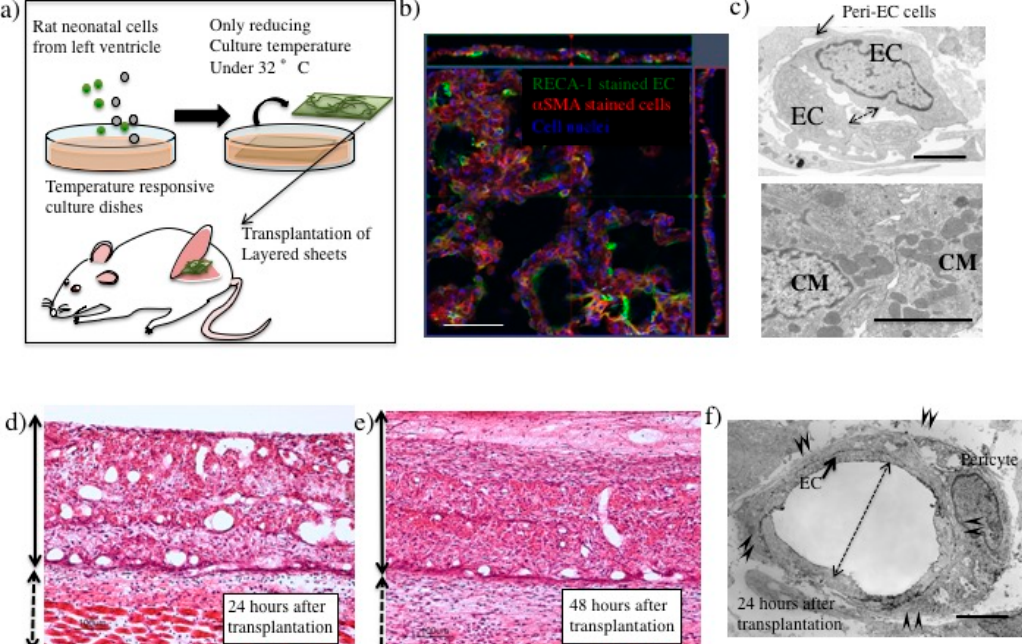
Figure 2. The pathological assessments of donor myocardial cell sheets before and after transplantation. ( a ) Procedures for myocardial cell sheet transplantation into rats. ( b ) Image of immunofluorescence staining of myocardial cell sheet cultured for 4 days in vitro by confocal microscopy. EC (rat endothelial cell antigen (RECA)-1: green), peri-EC cells ( α SMA: red), nuclei (Hoechst 33258). ( c ) Electron microscopic analysis of ECs and cardiomyocytes (CMs) in myocardial cell sheets cultured for 4 days in vitro. Peri-EC cells (arrow) already attached to ECs forming narrow lumens (two direction arrow). Lower image shows cardiomyocytes in the cell sheets. ( d ) Hematoxylin and eosin (H.E.) staining of a transplanted myocardial cell sheet 24 h after transplantation and ( e ) 48 h after transplantation. Side solid lines with two direction arrows indicate transplanted cell sheet area, and short dashed lines of two direction arrows indicate host tissue. ( f ) Vasculature lumens in transplanted myocardial cell sheets. Pericytes connected to ECs tightly (arrow-heads) to form large lumens (two directional arrow). Scale bar: ( b , d , e ) about 100 µ m, ( c , f ) 3.3 µ m. (The scale bar was added with estimation from original data.)